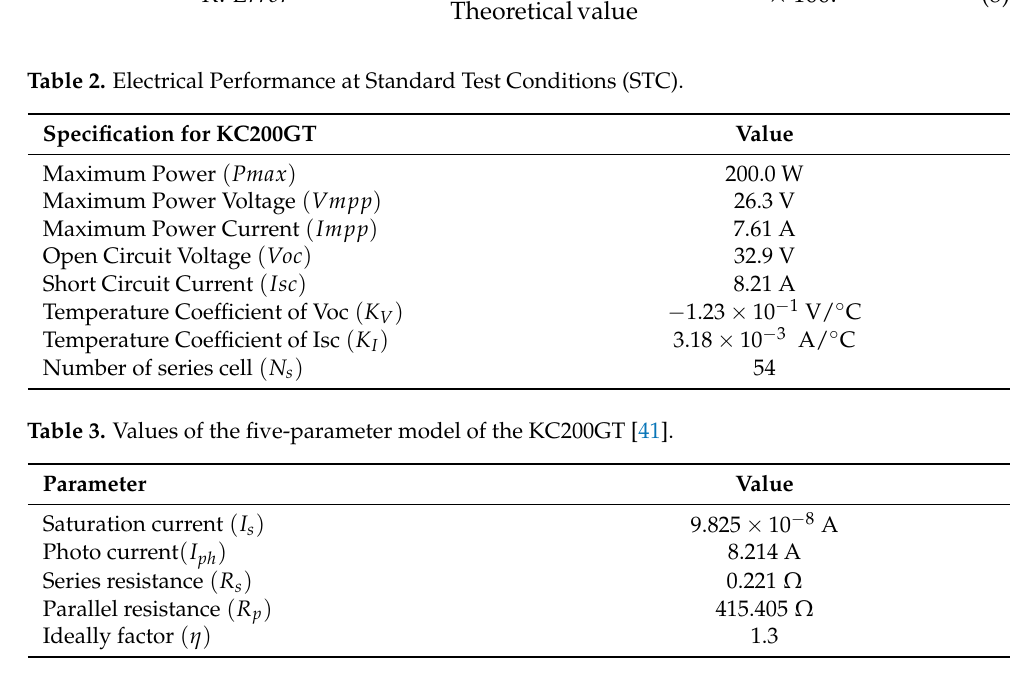
Table 4. Electrical performance of the 4 × 2